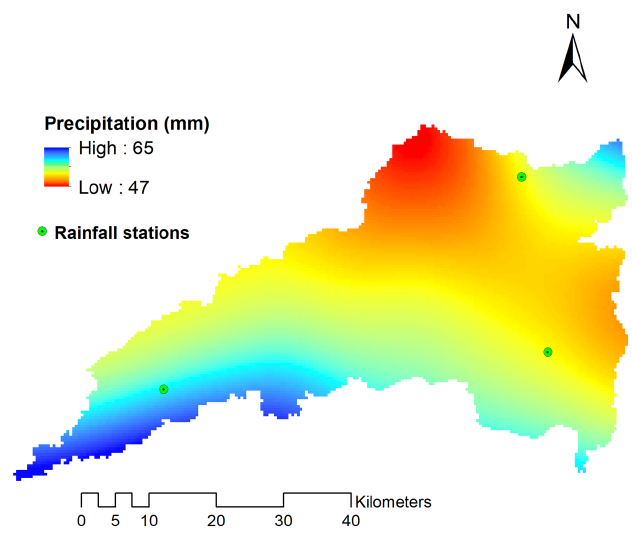
Figure 7. Maximum daily precipitation distribution map of the study area.